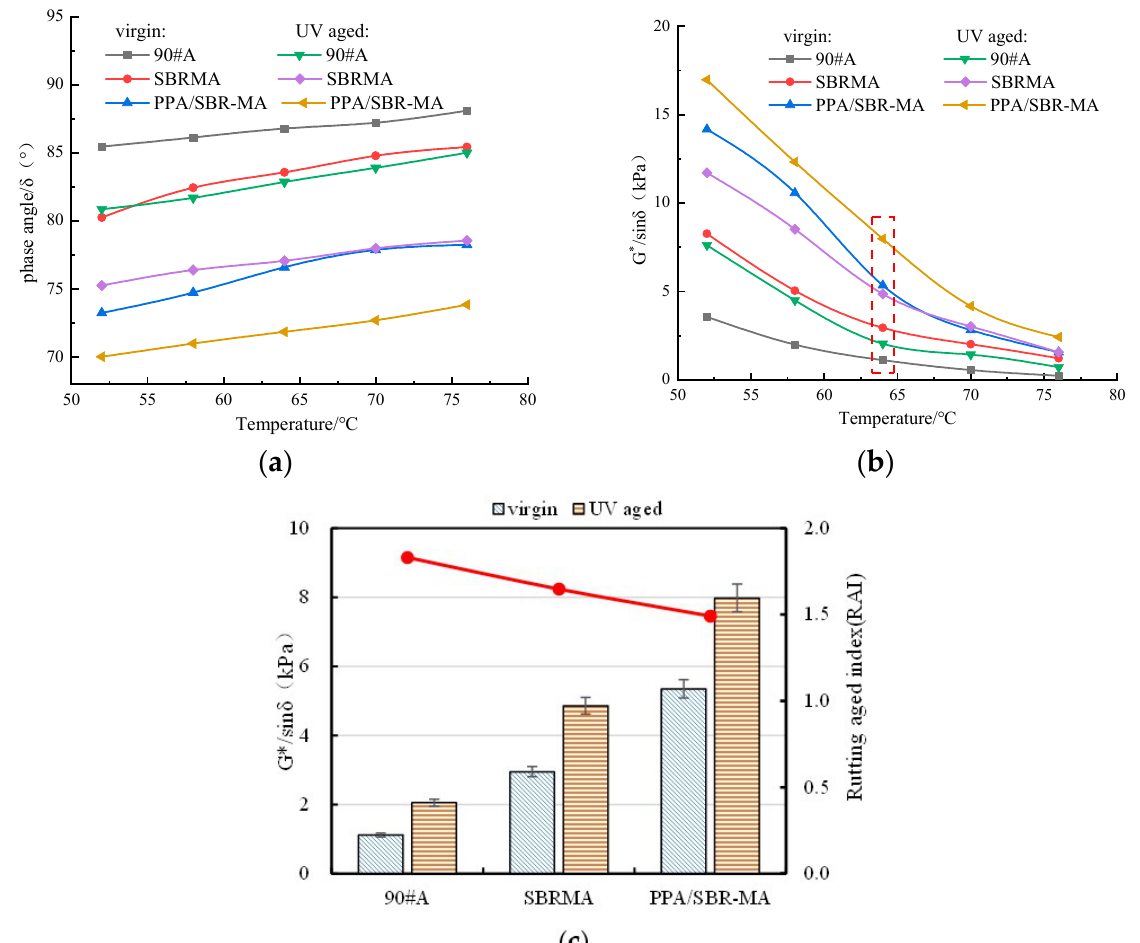
Figure 6. High temperature rheological properties results. ( a ) Phase angle of asphalt ( δ ); ( b ) Rutting factor (G ∗ /sin δ ); ( c ) Rutting factor and aged index at 64 ◦ C. The phase angle curves of the three asphalts all move downward after UV aging. The phase angles become smaller after UV aging, which indicates that the asphalts are hardened. The decreasing order of the values of the phase angle variable is SBRMA > PPA/SBR-MA > 90#A. For example, at 64 ◦ C, the phase angles of 90#A, SBRMA, and PPA/SBR-MA before UV aging are 82.85 ◦ , 77.06 ◦ , and 71.84 ◦ , respectively. Meanwhile, the phase angles of the three asphalts are reduced by 4.5%, 7.8%, and 6.2%, respectively, after UV aging. The